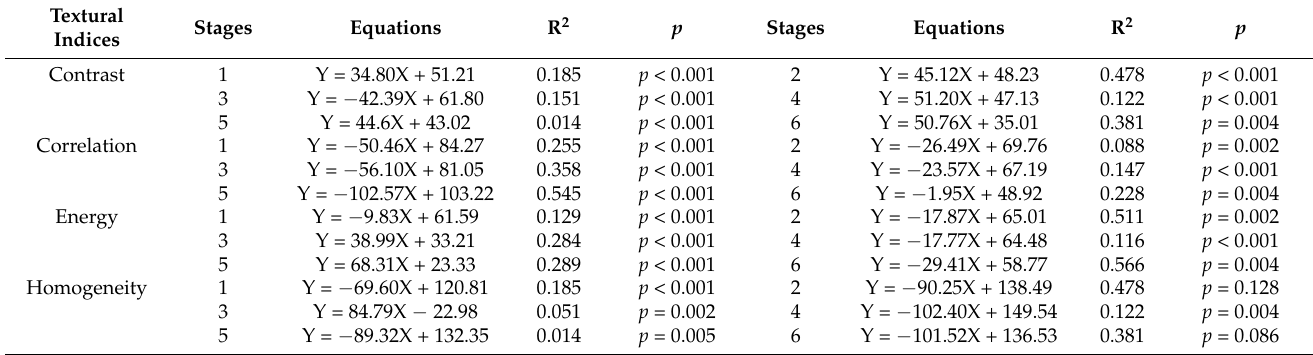
Table A3. The result of linear regression analysis between textural indices and SPAD values for different growth stages. The textural indices mean different textural information, and the stages are in according with the date of data acquisition in Figure 3. The Equation represents the linear regression equation, R 2 means the coefficient of determination, and the p means the significant